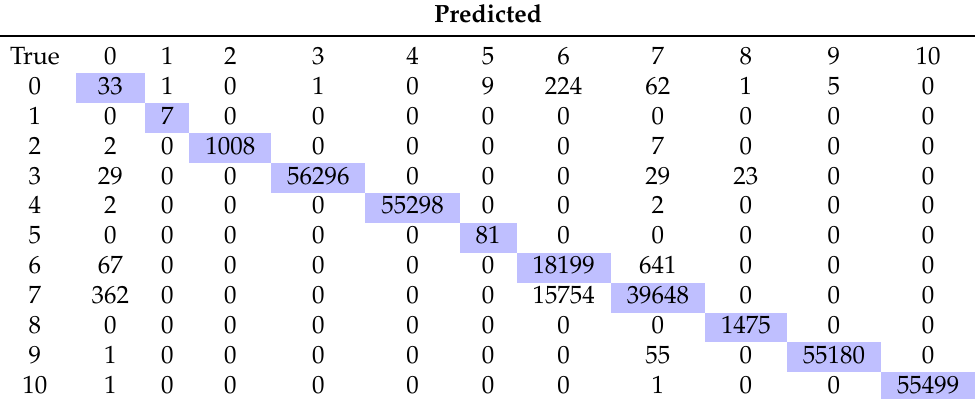
Table 47. NB confusion